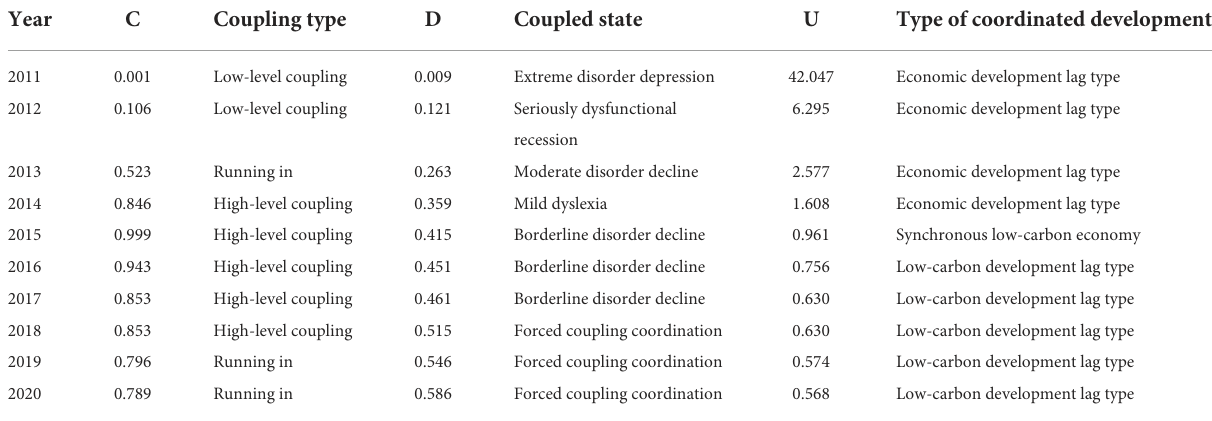
TABLE 8 Coupling degree of low-carbon development in Anhui